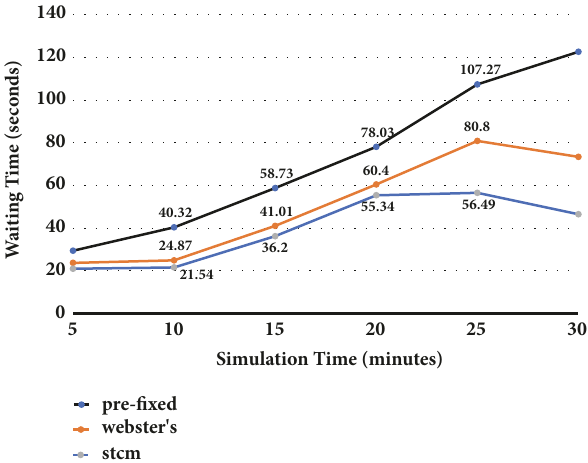
Figure 5: The comparison of the light control systems under heavy traffic flow.